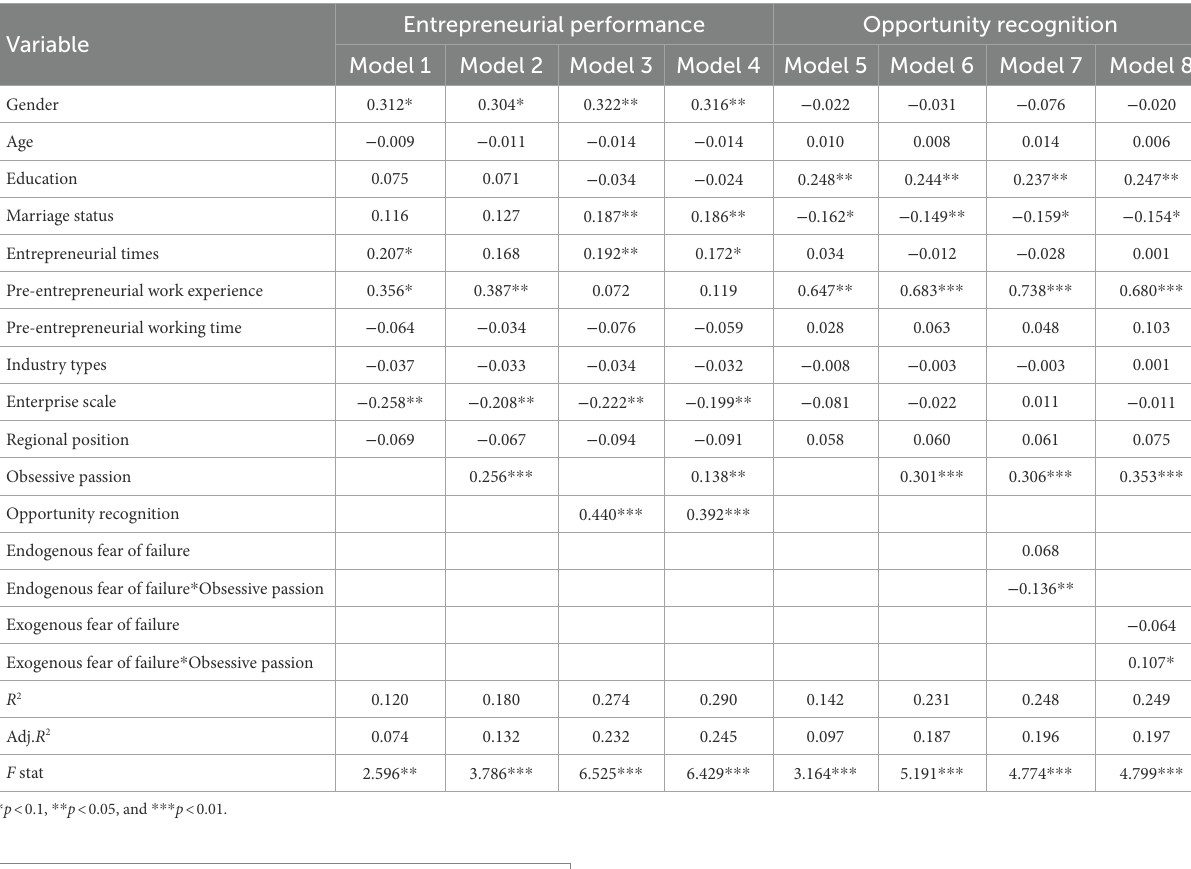
TABLE 4 Hypothesis test results.